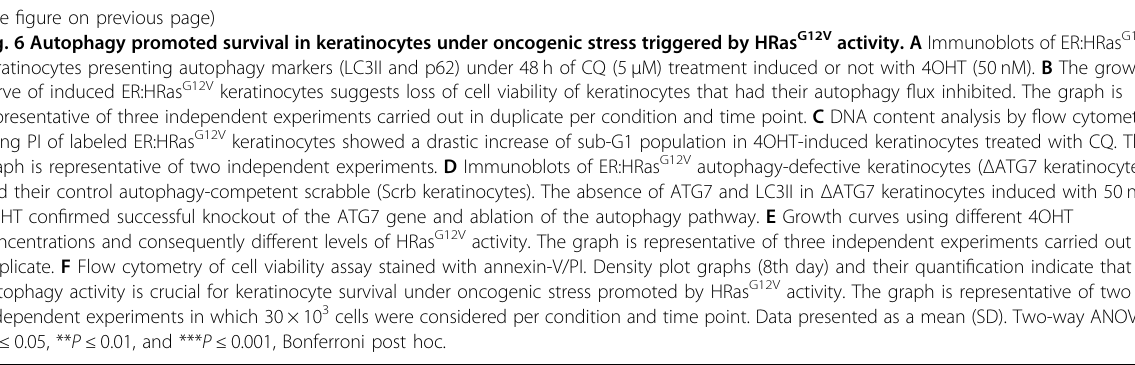
The results of Figure 4 indicated that ROS generation was the main cause of oncogenic stress triggered by